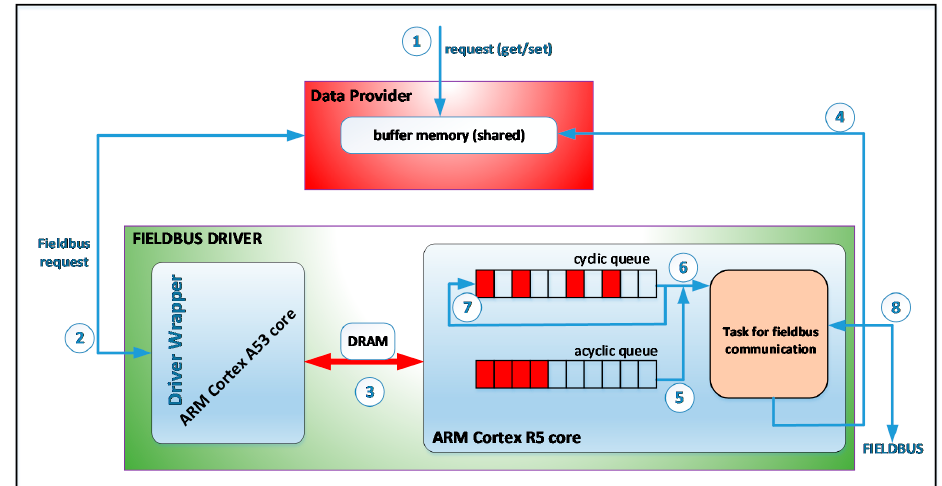
Figure 6. The operation diagram for a CANOpen fieldbus driver when a specialized core is used.